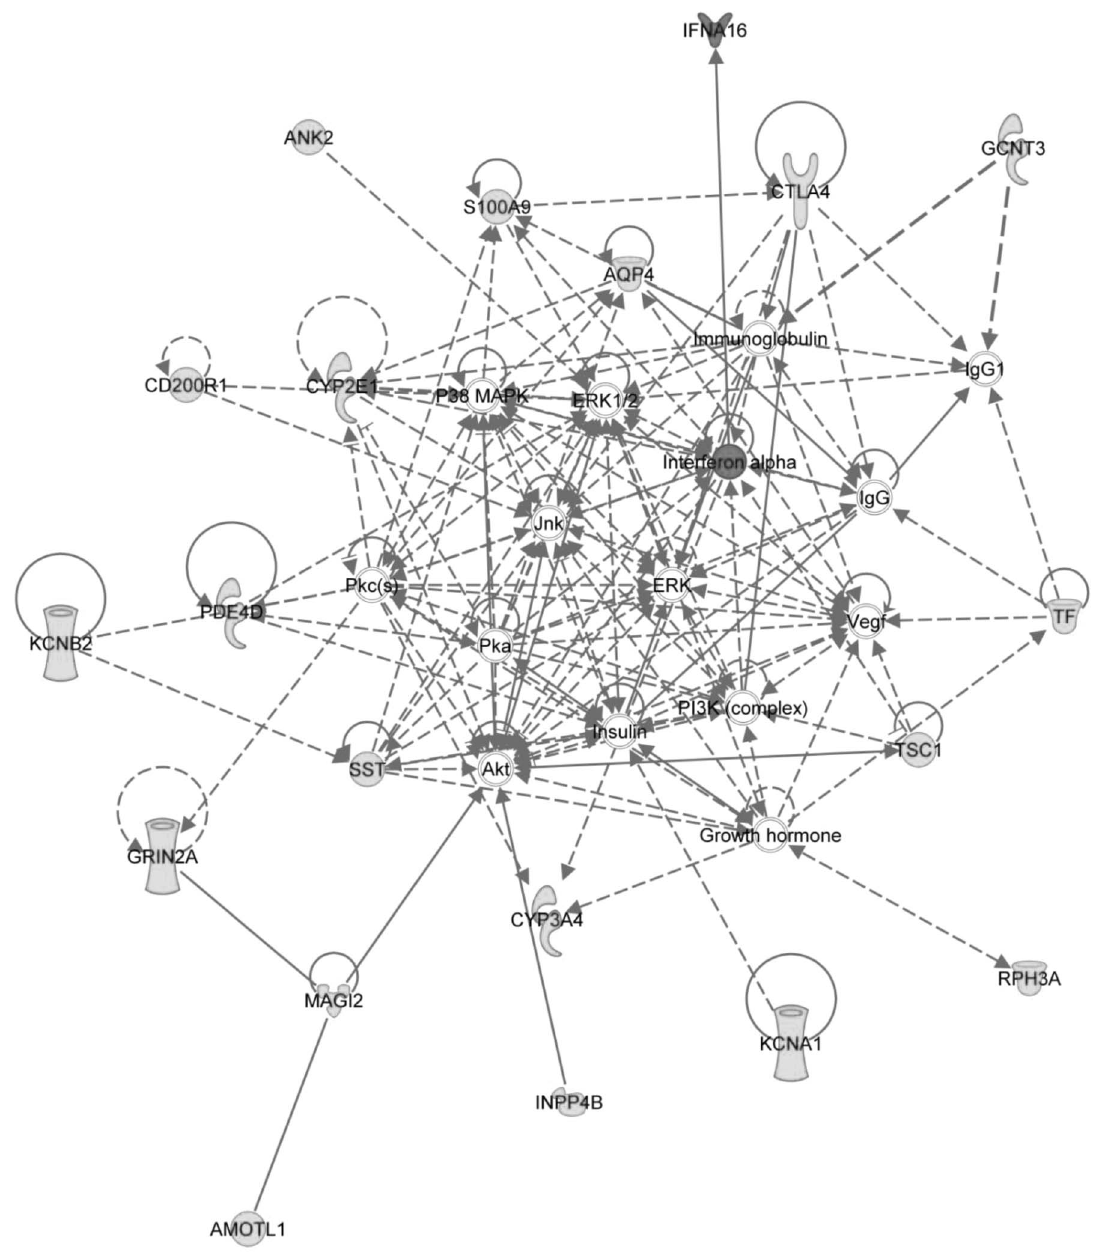
Figure 5. Network of differentially expressed genes. This network contains interconnections among 20 differentially expressed genes in response to HCV-core protein stimulation. Upregulated genes are indicated in green, and downregulated genes and gene classes in red. These differentially expressed genes include the cytotoxic T lymphocyte associated protein CTLA4, the cytochrome P450 proteins CYP2E1 and CYP3A4, the potassium voltage gated proteins KCNA1 and KCNB2, and the cell surface receptor CD200R1.